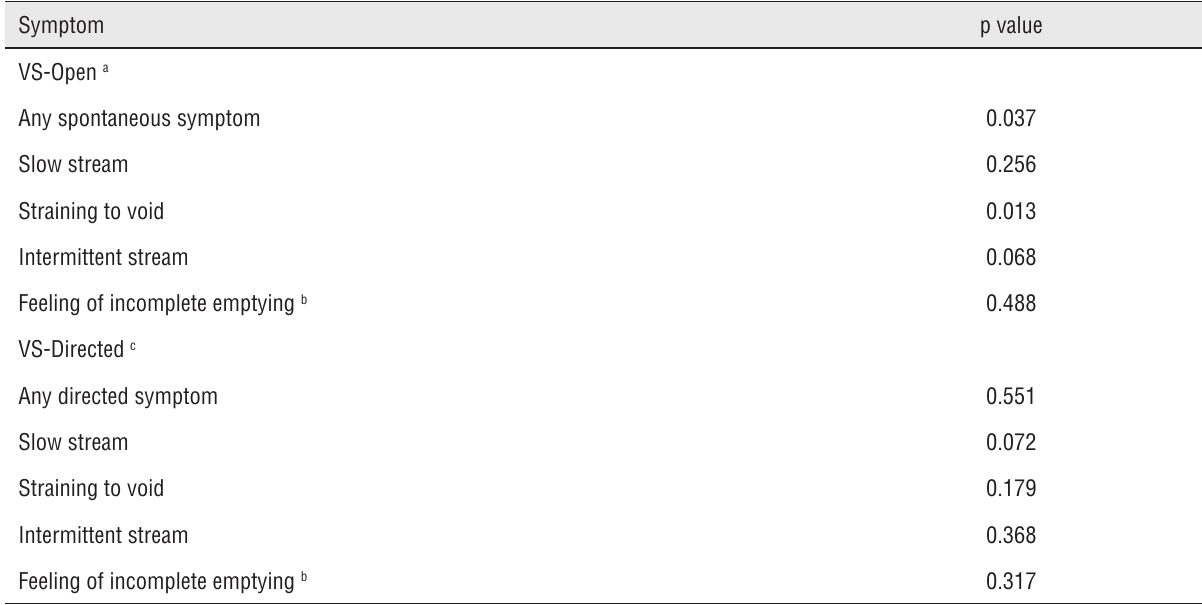
Table 3 - Statistical associations between voiding dysfunction and voiding symptoms in women with previous anti- incontinence